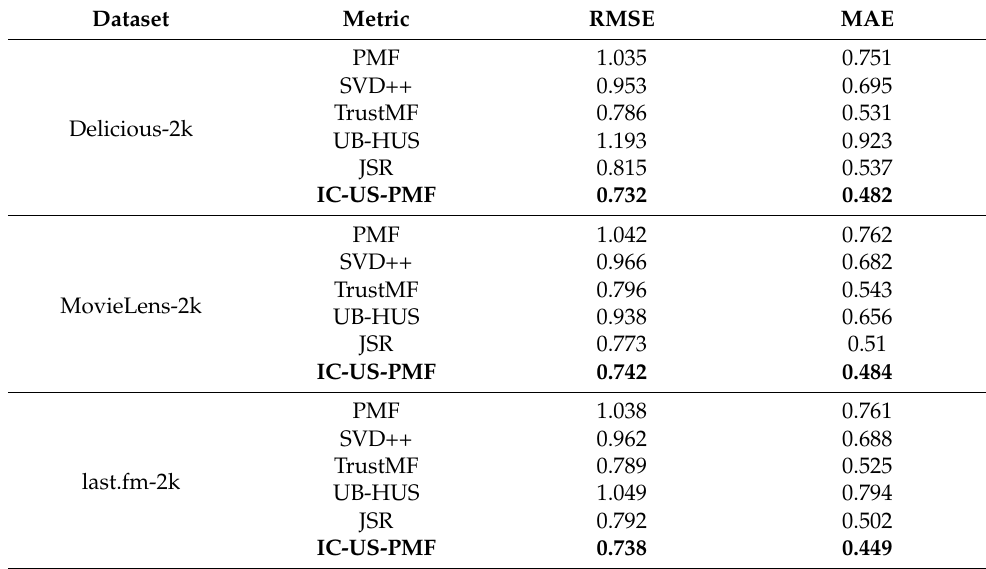
Table 7. Comparison of recommendation performance of each algorithm on cold user